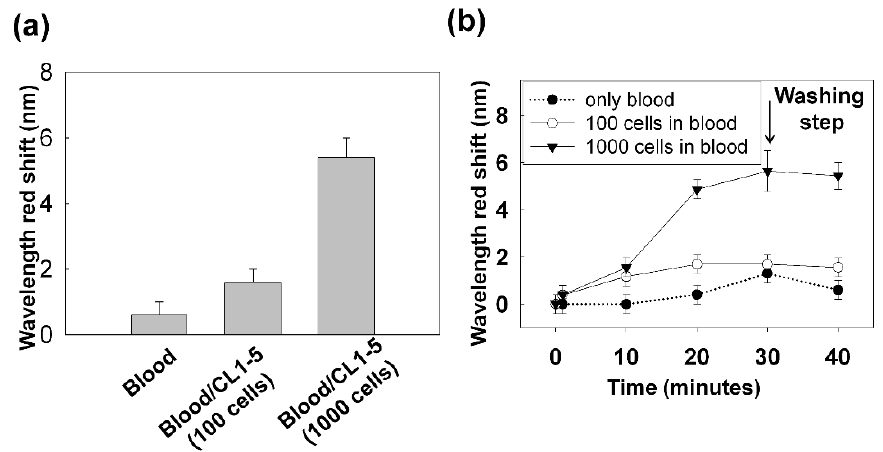
Figure 4. ( a ) DCM was applied to 1 mL of blood sample spiked with CL1-5 cells. The SPR response at 40 min for the blood sample without the spiked cells and the blood sample spiked with 100 and 1000 cells are shown. ( b ) The temporal SPR response that indicates the progression of the cell capturing on the gold nanoslits. Sample was introduced to the chip within 30 min. At 30 min, PBS buffer as the washing buffer was introduced. Each data set is the average of two or three measurements. The error bars lengths have been set to either the measurement standard deviation or the spectrometer resolution (±0.4 nm) whichever is